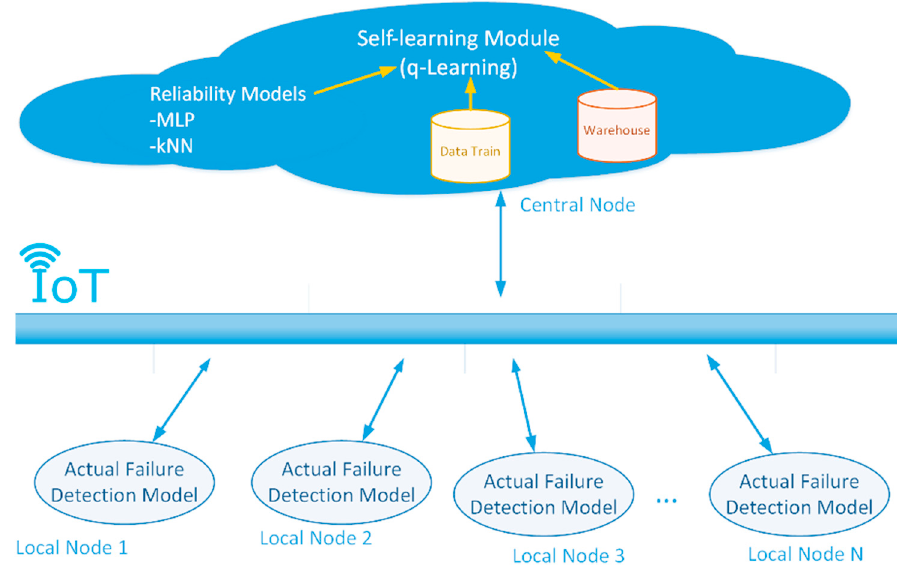
Figure 7. Flow diagram between the global node (self-learning module), IoT network, and local nodes (actual failure detection model).